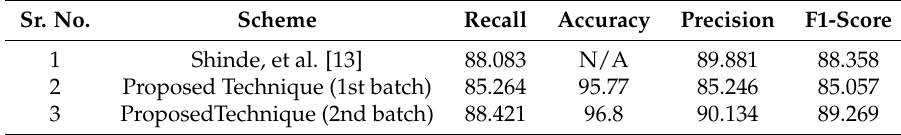
Table 8. Comparison of proposed method with the state-of-the-art in terms of performance matrices. Sr. No. Scheme Recall Accuracy Precision F1-Score 1 Shinde, et al.